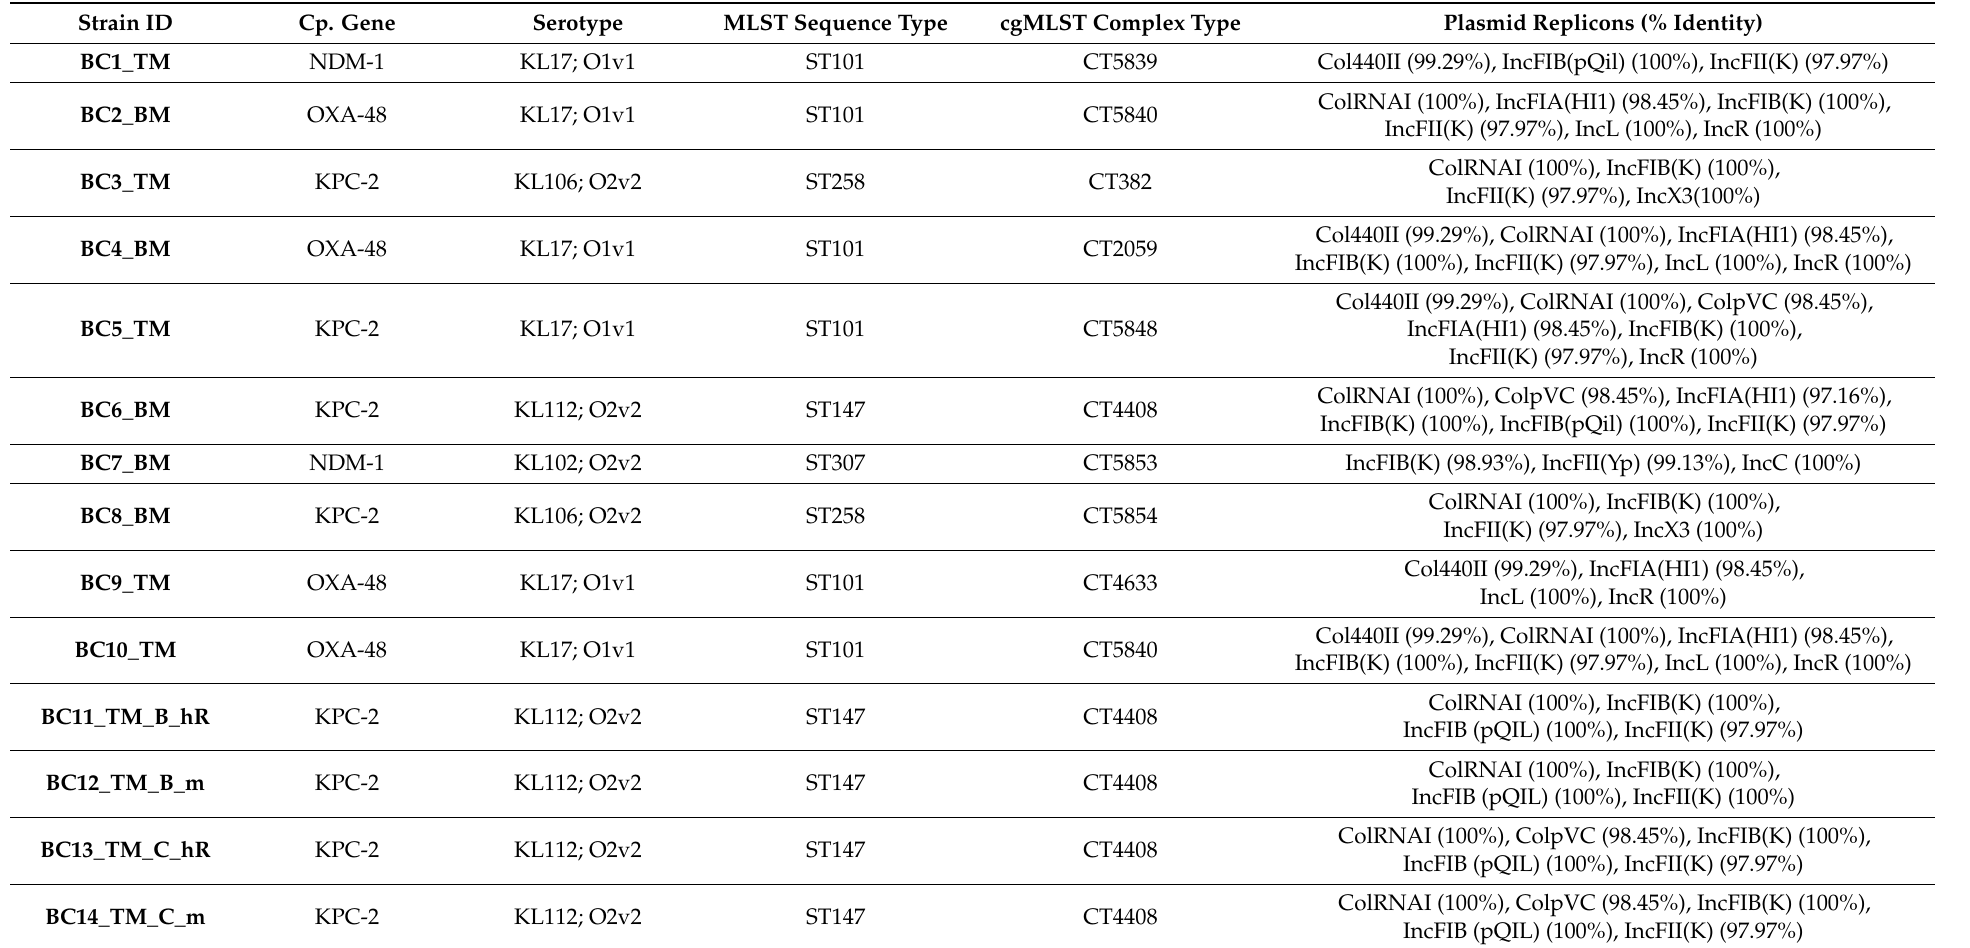
Table 7. Serotype, MLST, cgMLST, and plasmid replicons of all